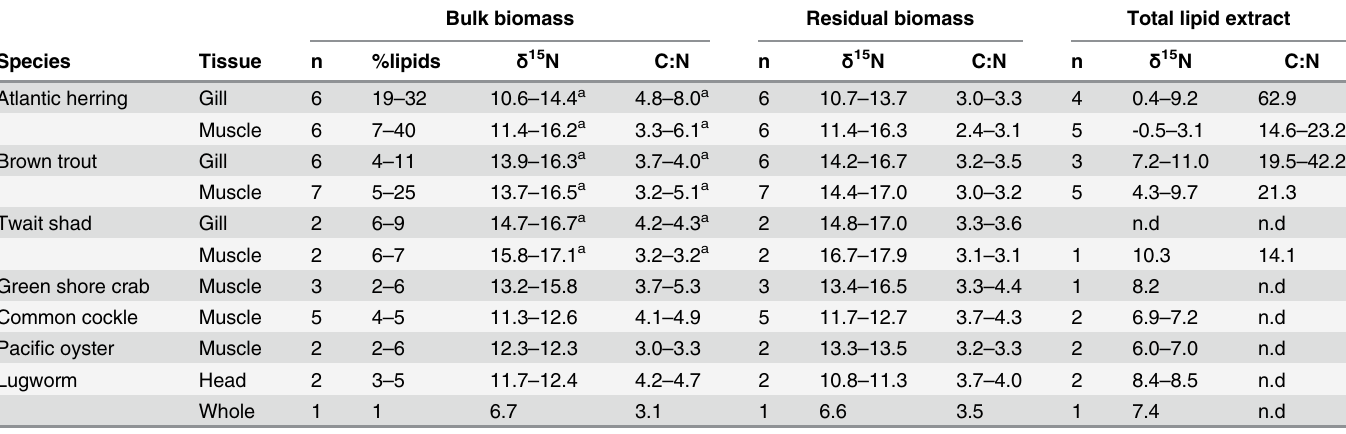
Table 1. Ranges of δ 15 N values and C:N ratios for bulk biomass, residual (lipid-free) biomass and lipids (total lipid extract) per species and tissue type. n = number of individuals analyzed. Standard deviation of δ 15 N values from replicate measurements were for bulk and lipid-free biomass (cid:3) 0.6 ‰ , for total lipid extract (cid:3)